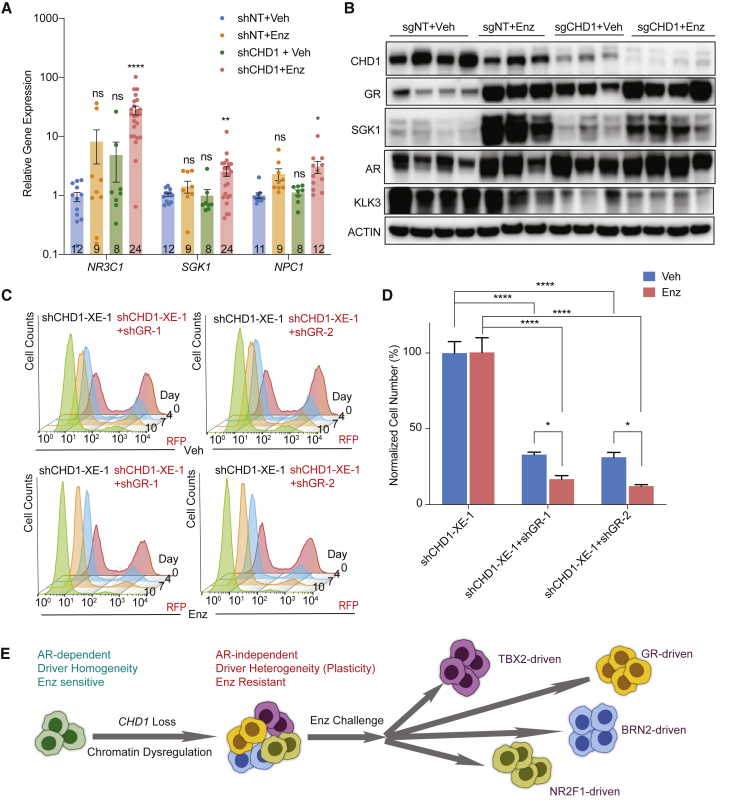
GR Inhibition Has Significant Antitumor Effect on Antiandrogen-Resistant Tumors with CHD1 Loss(A) Relative gene expression of NR3C1 and GR target genes in tumors collected from LNCaP/AR xenografts, all normalized and compared with shNT + Veh group. Mean ± SEM is presented. p values were calculated using two-way ANOVA, and numbers of biological replicates are presented.(B) Western blot showing AR, GR, and their downstream target genes in xenografted LNCaP/AR tumors. For (A) and (B), Enz denotes enzalutamide at 10 mg/kg from day 1 of grafting. Veh denotes 0.5% CMC + 0.1% Tween 80.(C) Histograms of representative FACS-based competition assay showing the distribution of shCHD1-XE-1 cells (RFP-negative) versus shCHD1-XE-1 cells transduced with shGR (RFP-positive). The distributions on different days are presented in different colors.(D) Relative cell number of shCHD1-XE-1 cells transduced with annotated inducible shRNAs, normalized to shCHD1-XE-1 + Veh. Cells were treated with 250 ng/mL doxycycline for 48 h, and then 7 days of 10 μM enzalutamide (Enz) or DMSO (Veh) before cell numbers were counted. Mean ± SEM is presented, and p values were calculated by two-way ANOVA, with three biological replicates in each group.(E) Model depicting the chromatin dysregulation (plasticity) and antiandrogen resistance in mCRPC due to CHD1 loss.For all panels, ∗∗∗∗p < 0.0001, ∗∗∗p < 0.001, ∗∗p < 0.01, ∗p < 0.05. See also Figure S8.